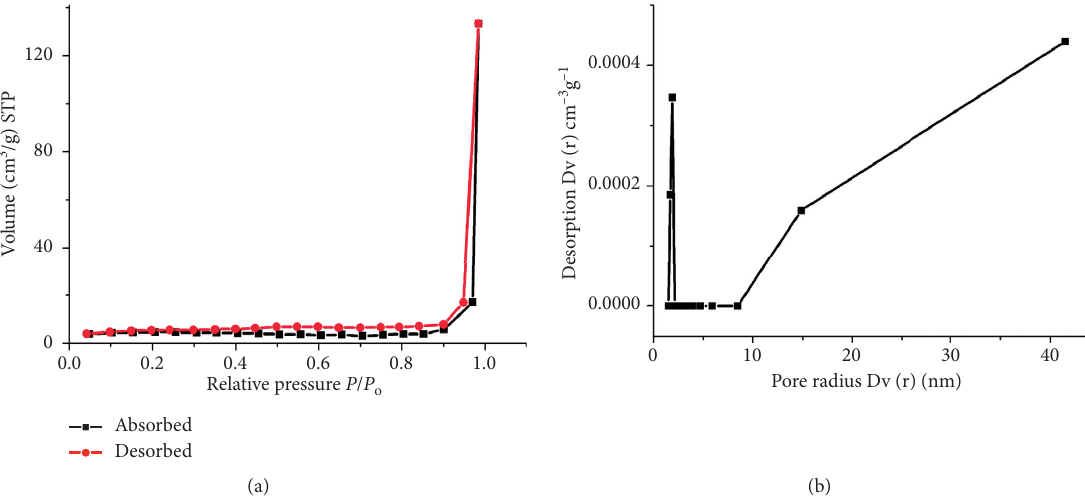
Figure 12: (a) N 2 sorption isotherms and (b) pore size distribution of Fe 3 O 4 @SiO 2 @LEuH@PW 10 nanospheres (type III isotherm): the abrupt rise near P / P o � 1 is due to the pores within the nanomaterial and not on the surface of the